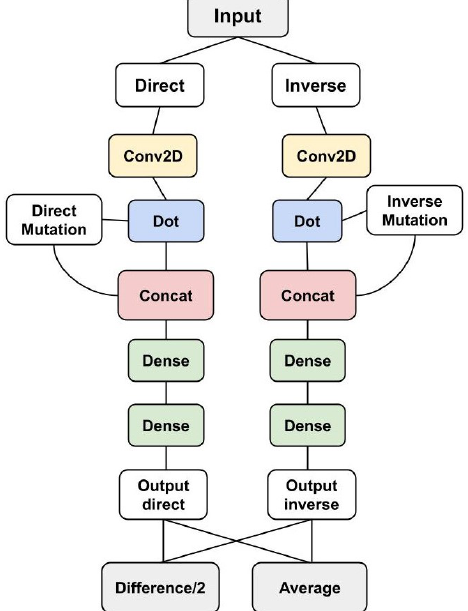
Figure 2. Complete ACDC-NN-Seq architecture. The module displayed in Figure 1 is used for both direct and reverse variations. Given a variation, we provide to the network its coding to the left, and the coding to the reverse variation to the right. A final layer takes the average and the difference between the two outputs. The difference computes ( ∆∆ G direct − ∆∆ G inverse ) /2, which in case of perfect antisymmetry is exactly equal to ∆∆ G . The average computes ( ∆∆ G direct + ∆∆ G inverse ) /2, which in case of perfect antisymmetry is equal to 0. The ACDC-NN-Seq outputs are estimations of the target ∆∆ Gs learned during the training phase. The two Siamese networks have shared weights, both in the convolutional and the dense parts of the